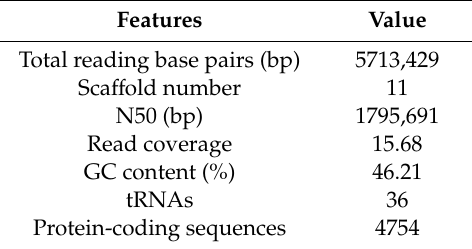
Table 1. Features of the Cellvibrio sp. Bin79